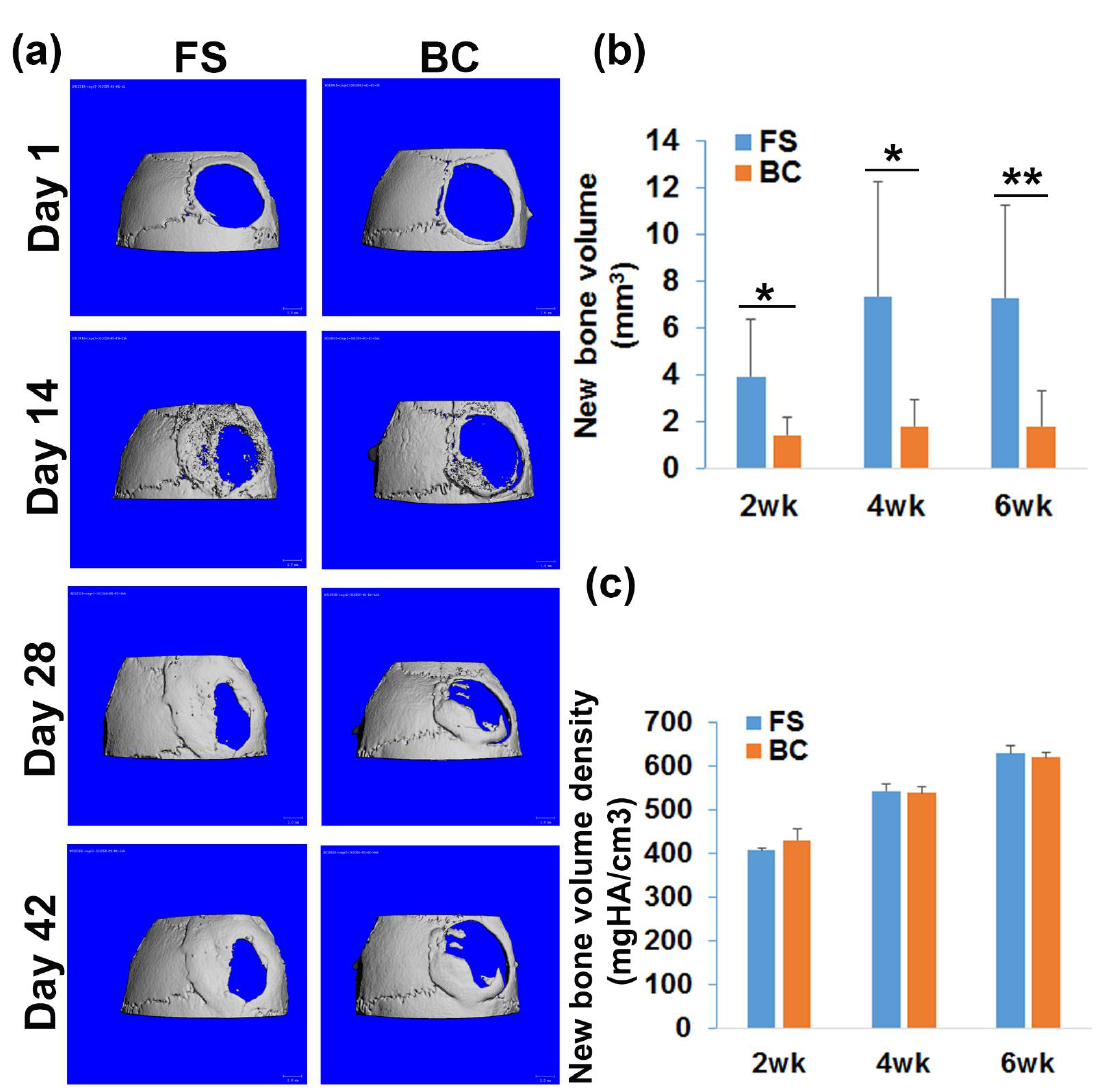
Figure 3. MicroCT analysis of bone regeneration. ( a ) MicroCT 3D images at different time points post-surgery. Scale bars = 1 mm. ( b ) Quantification of the new bone volume. There was significantly less new bone formed in the BC group than in the FS group. ( c ) New bone volume density quantification. Bone density increased as new bone matured. No statistically significant differences were found between the BC and FS groups. * p < 0.05, ** p < 0.01.